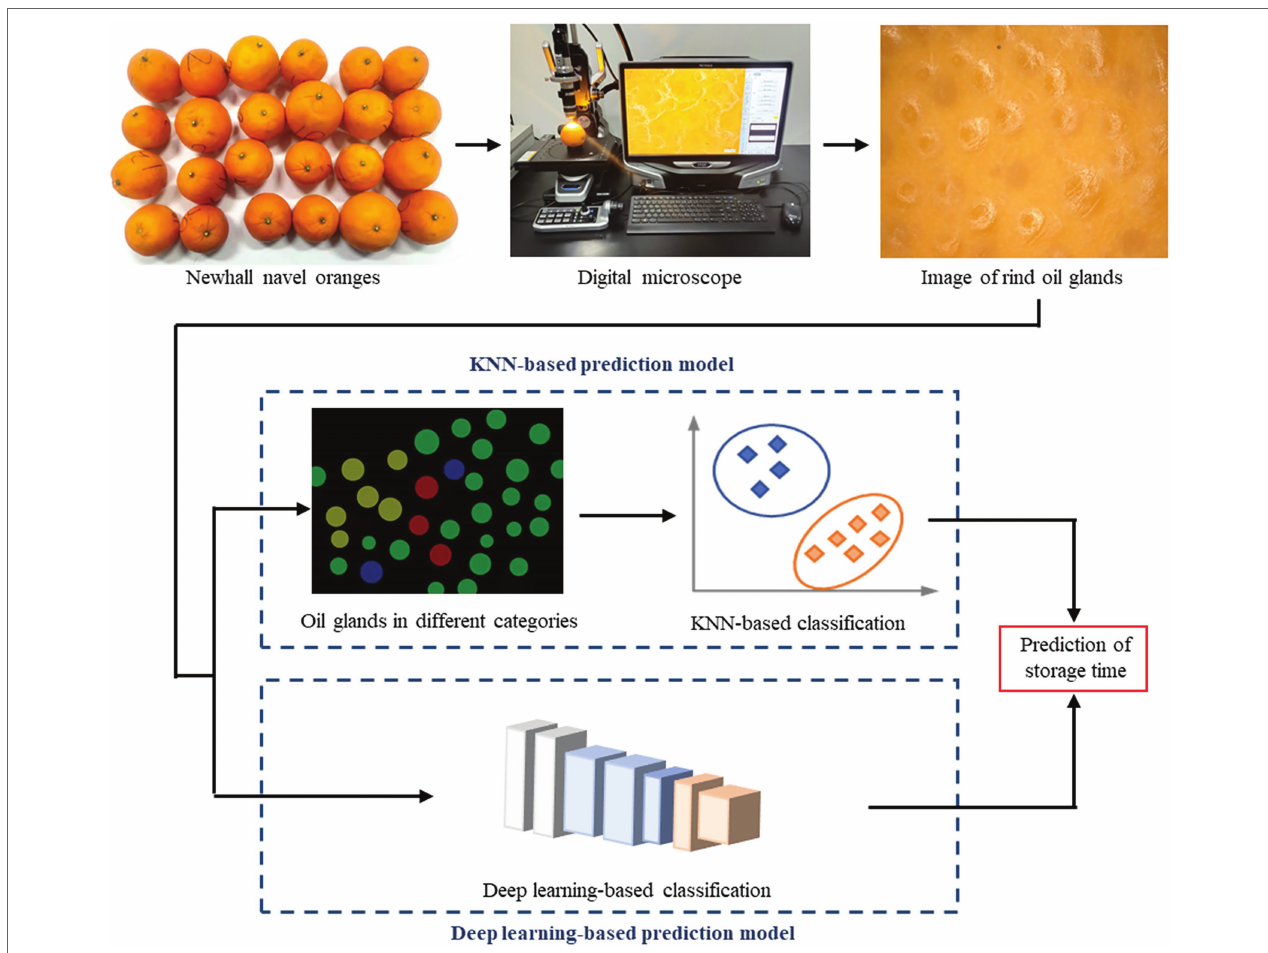
FIGURE 1 | Flowchart of the development of the K-Nearest Neighbors (KNN) and deep learning-based prediction models for the storage time of the Newhall